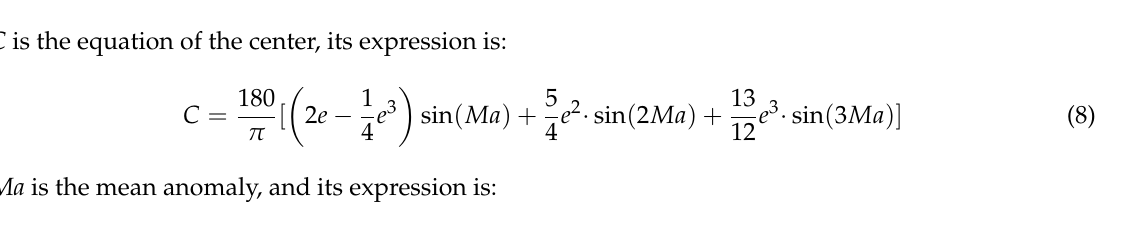
Figure 5. Comparison between Equations (5) and (6) and IMMCE calculation to choose the Sun’s declination equation.